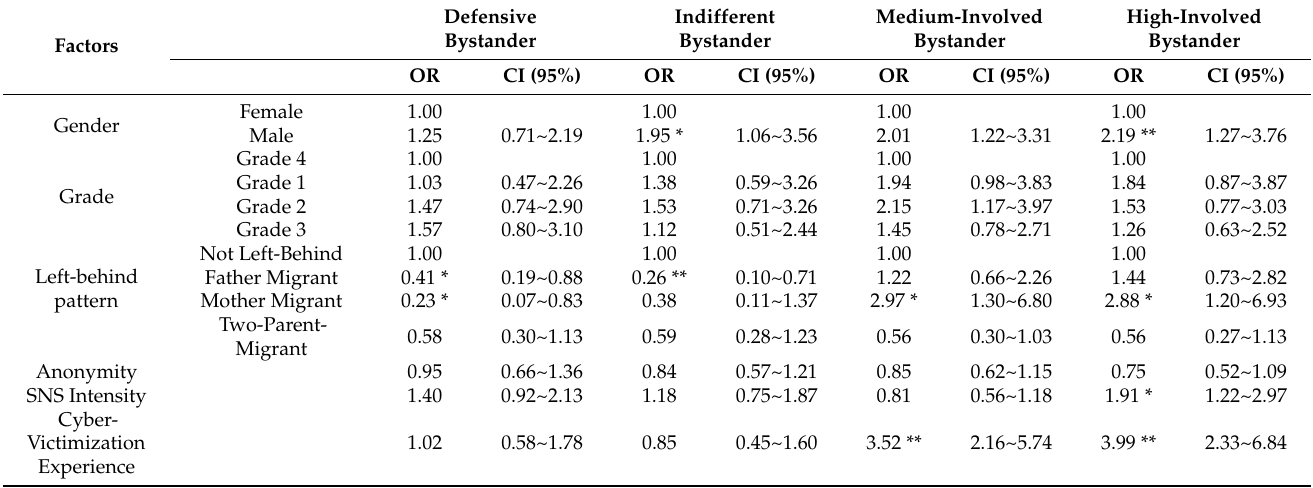
Table 3. Association of the influencing factors with different latent classes of the